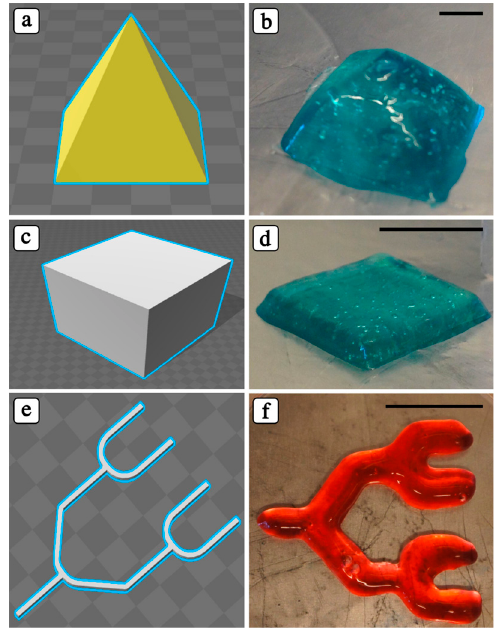
Figure 4. CAD and optical images of 3D-printed objects. All solids were printed with a layer thickness of 200 μ m and a distance between fibers in the X–Y plane of 500 μ m. Scale bars: 10 mm.